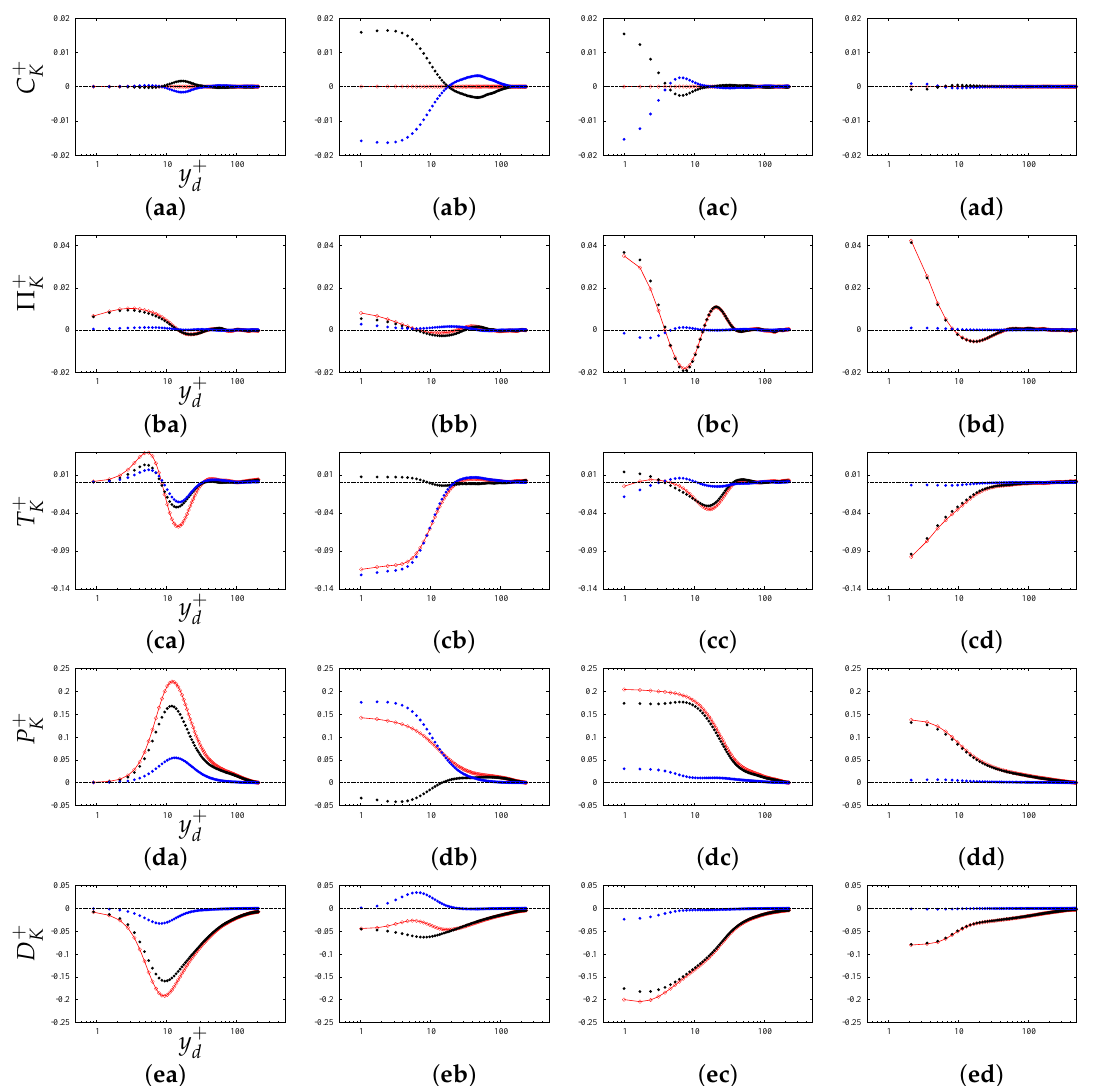
Figure 9. Turbulence kinetic energy budgets for smooth pipe ( SM , panels aa , ba , ca , da , ea ); rectangular bars ( SLL , panels ab , bb , cb , db , eb ); triangular bars ( TLS , panels ac , bc , cc , dc , ec ); and staggered cubes ( CS , panels ad , bd , cd , dd , ed ). Convection terms: panels aa – ad ; pressure-velocity turbulent: panels ba – bd ; turbulent diffusion: panels ca – cd ; production: panels da – dd ; total dissipation: panels ea – ed . The red lines denote terms in Equation (2); blue and black lines denote coherent and incoherent contributions in Equation (6), and open circles their